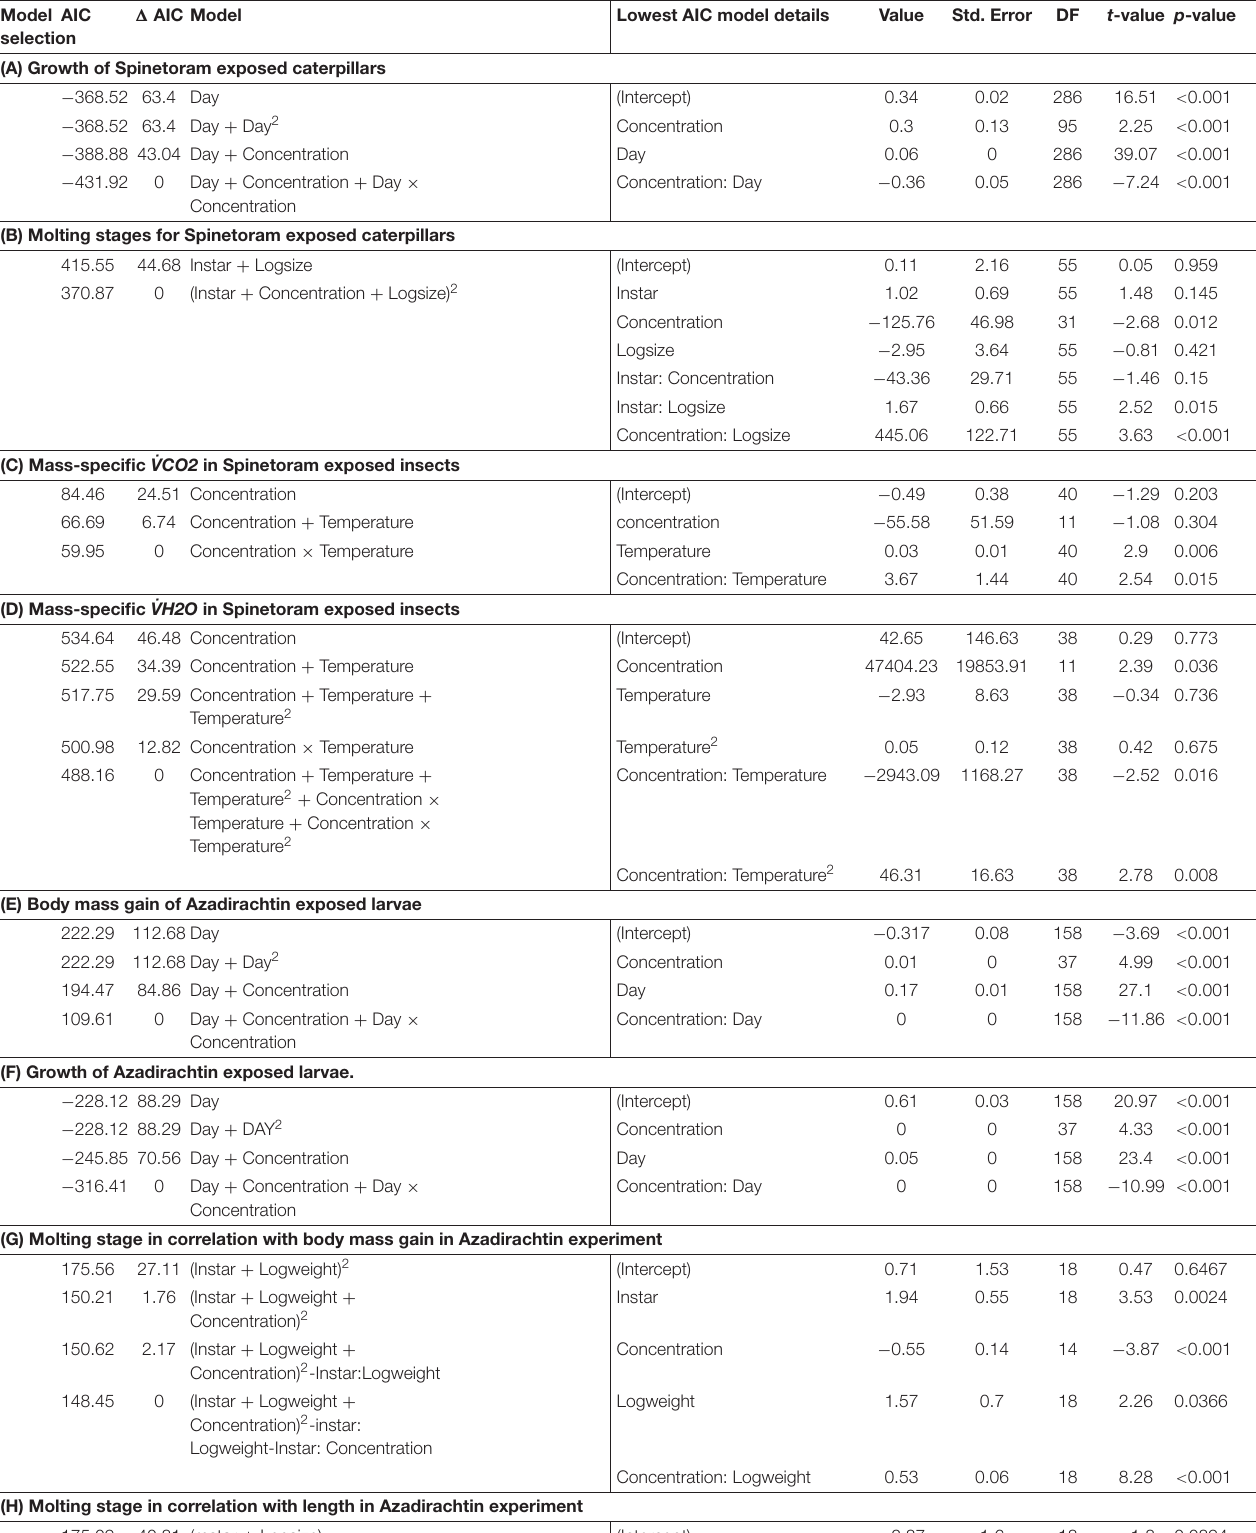
TABLE 1 | Model selection for (A) growth of Spinetoram exposed caterpillars; (B) moulting stages for Spinetoram exposed caterpillars; (C) mass-specific VCO 2 in Spinetoram exposed insects; (D) mass-specific ˙VH 2 O in Spinetoram exposed insects; (E) body mass gain of Azadirachtin exposed larvae; (F) growth of Azadirachtin exposed larvae; (G) molting stage in correlation with body mass gain in Azadirachtin experiment; (H) molting stage in correlation with length in Azadiractin experiment; (I) mass-specific VÌ ˘GCO2 of Azadirachtin exposed insects and a control group; and (J) mass-specific ˙VH 2 O loss for Azadirachtin exposed insects and a control group. Model